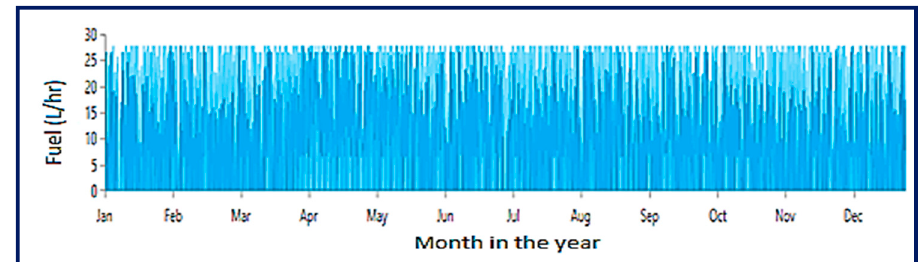
Figure 9. Monthly electric power production.